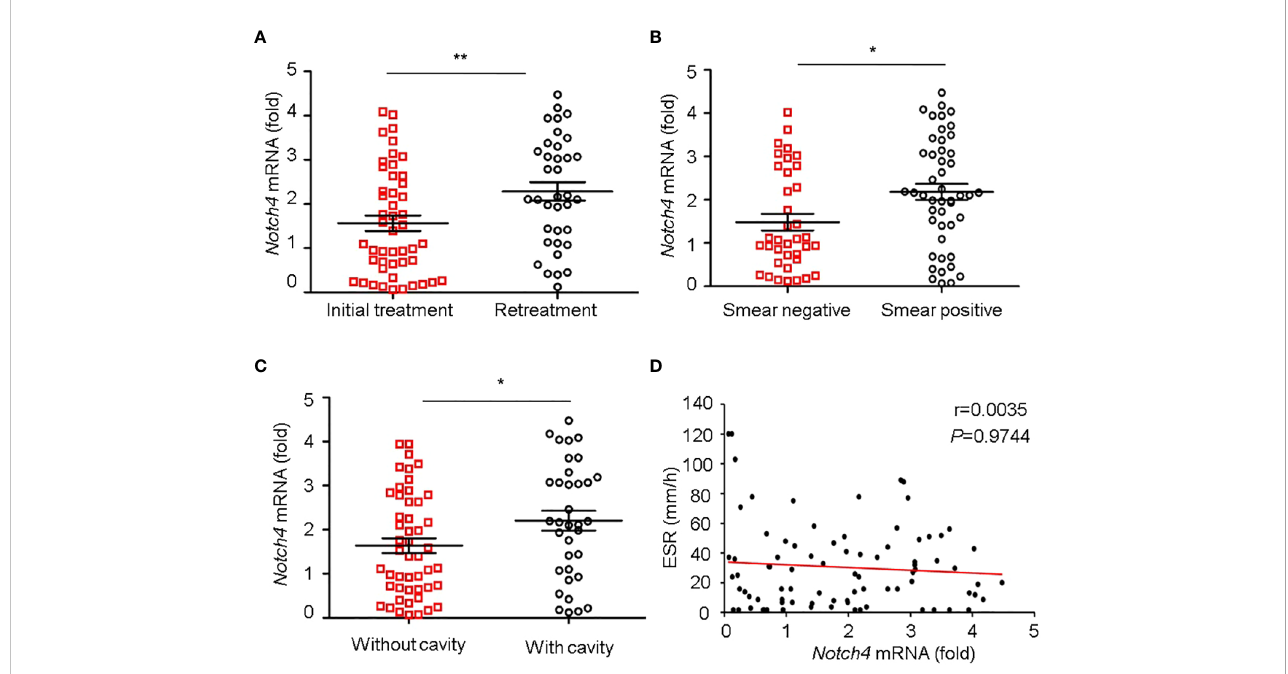
FIGURE 3 Correlation between Notch4 expression and clinical characteristics. (A-D) qRT-PCR detection of Notch4 expression in PBMCs from 84 TB patients and analysis the correlation between Notch4 expression and the status of patients with initial treatment or retreatment (A) , bacillary load in sputum (B) , lung fi eld with cavity or without cavity (C) , and erythrocyte sedimentation rate (D) . The data were expressed as mean ± SEM by the Student t test, * P < 0.05 and ** P <